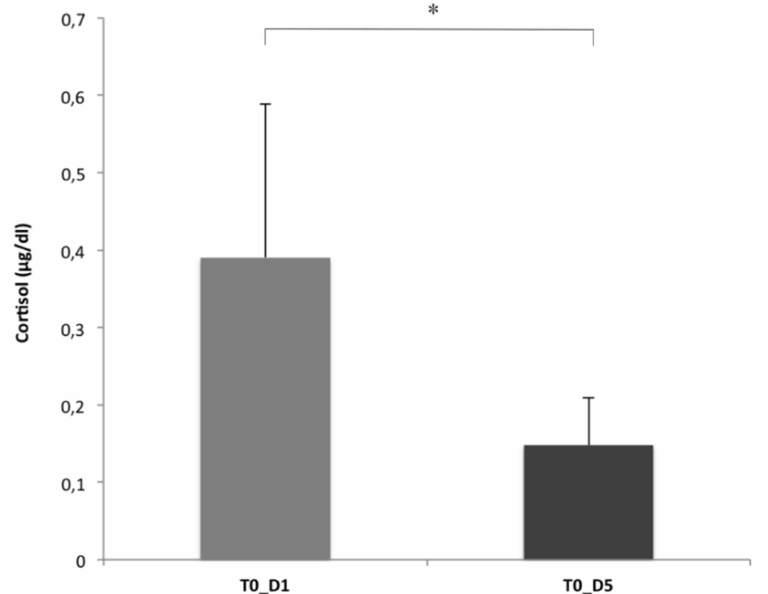
Figure 1. Cortisol concentration in the saliva samples collected at T0 on D1 and D5 (means and S.E.M. are shown; Wilcoxon signed rank test). * p <